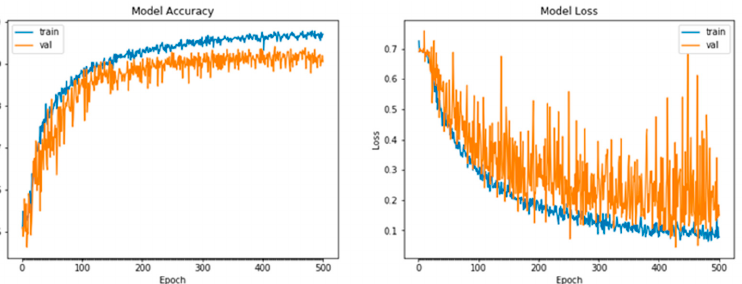
Figure 1. Plot of best-performing ADAM with increasing CNN depth and width on Cats and Dogs.